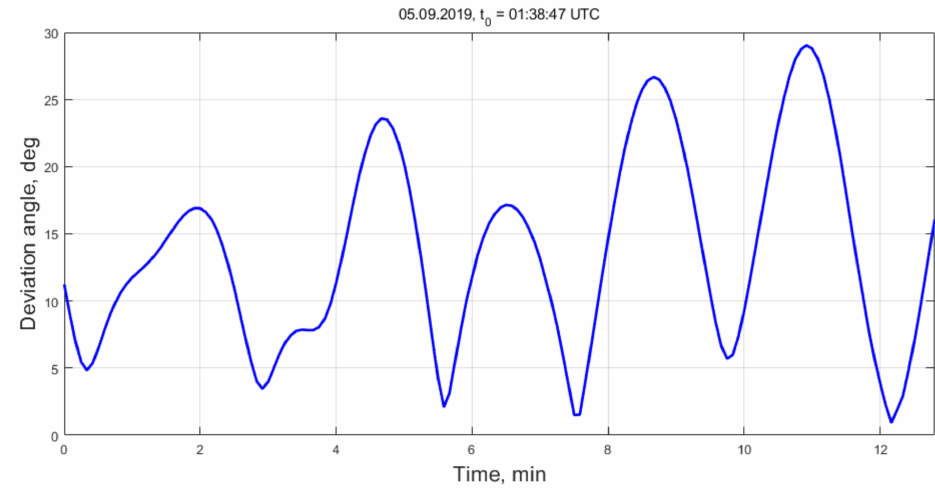
Figure 16. Deviation of OZ axis from the direction of the incoming air